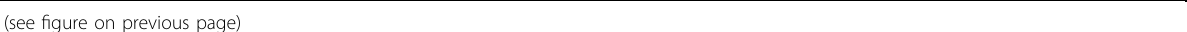
Fig. 2 CAP failed to inhibit the in fi ltration of peripheral immune cells into the LPS-treated SN. a Every sixth serial section was selected and immunostained to identify expression of MPO, ED1, CD3, CD20, and OX-6 in the LPS (5 µg/3 µl)-treated SN at the indicated time points. Arrows indicate CD3 + cells. b – f The numbers of MPO + , ED1 + , CD3 + , CD20 + , or OX-6 + cells in the SN. The data are presented as the mean±SEM of 4 to 5 animals per group. *p < 0.05, **p < 0.01, ***p < 0.001 compared with PBS-injected SN treated with vehicle; + p < 0.05, +++ p < 0.001 compared with LPS-injected SN treated with vehicle at 8 h. ^ p < 0.05, ^^^ p < 0.001 compared with LPS-injected SN treated with vehicle at 12 h; # p < 0.001, compared with LPS-injected SN treated with vehicle at 1 d (ANOVA and Bonferroni method). g A FITC-labeled albumin assay demonstrated that CAP did not prevent LPS-induced BBB disruption in the SN. The results represent 4 – 5 animals per group. Scale bar: a 25 µm; g 250